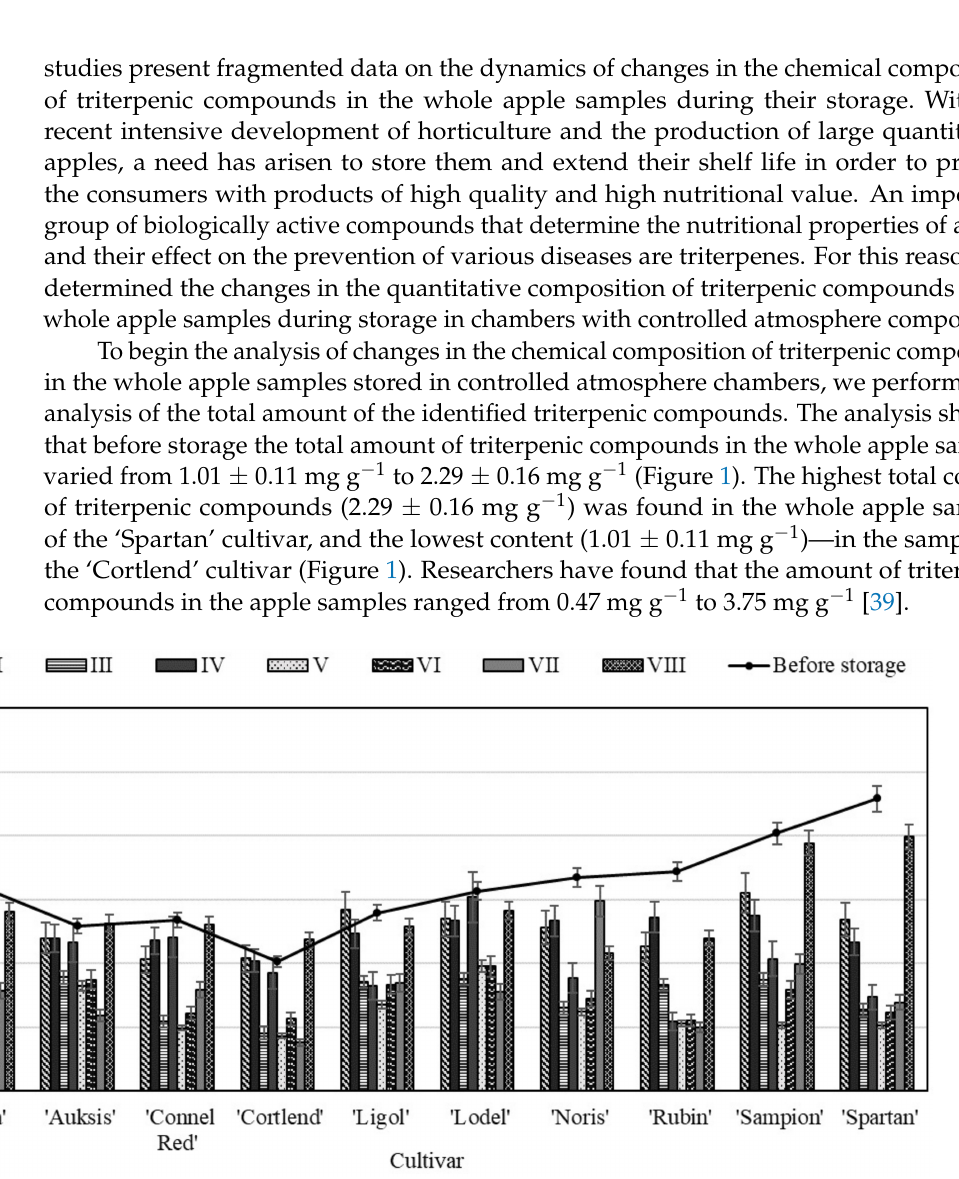
Figure 1. Changes in the total amount of triterpenic compounds in the whole apple samples before and after storage in